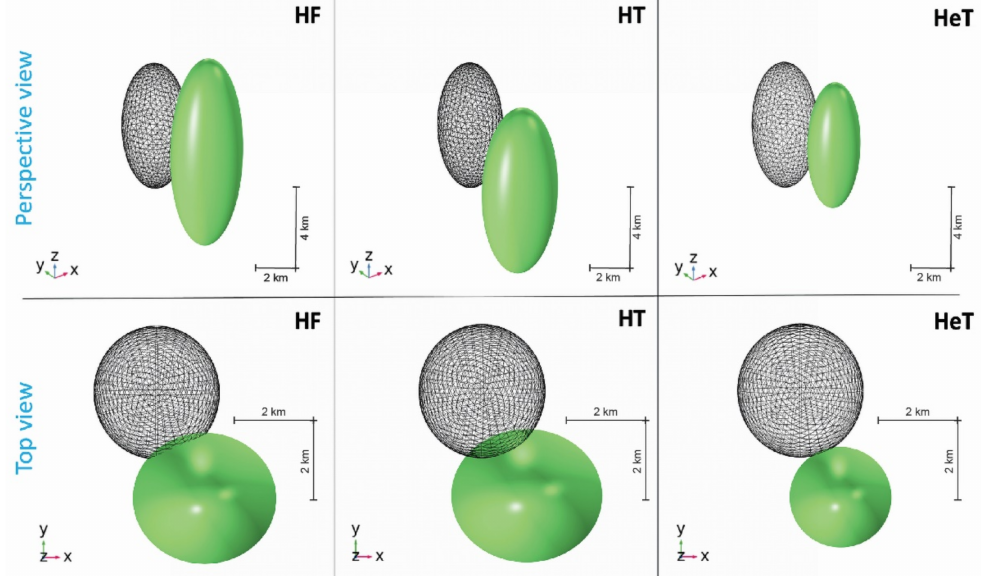
Figure 4. Perspective views and top views of the source shape before (black wireframe) and after (green shaded) the joint inversion of EDM and leveling data for the period 1985–1999. HF: homogeneous flat crust; HT: homogeneous crust with topography; HeT: heterogeneous crust with topography.